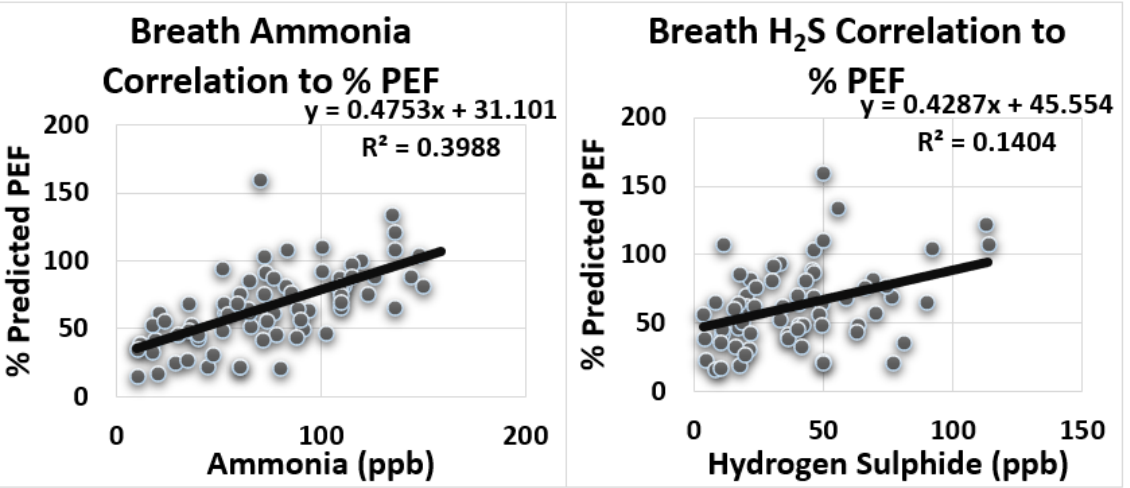
Figure 5. Correlation between exhaled breath ammonia and hydrogen sulfide to peak expiratory flow (PEF) (% of predicted).